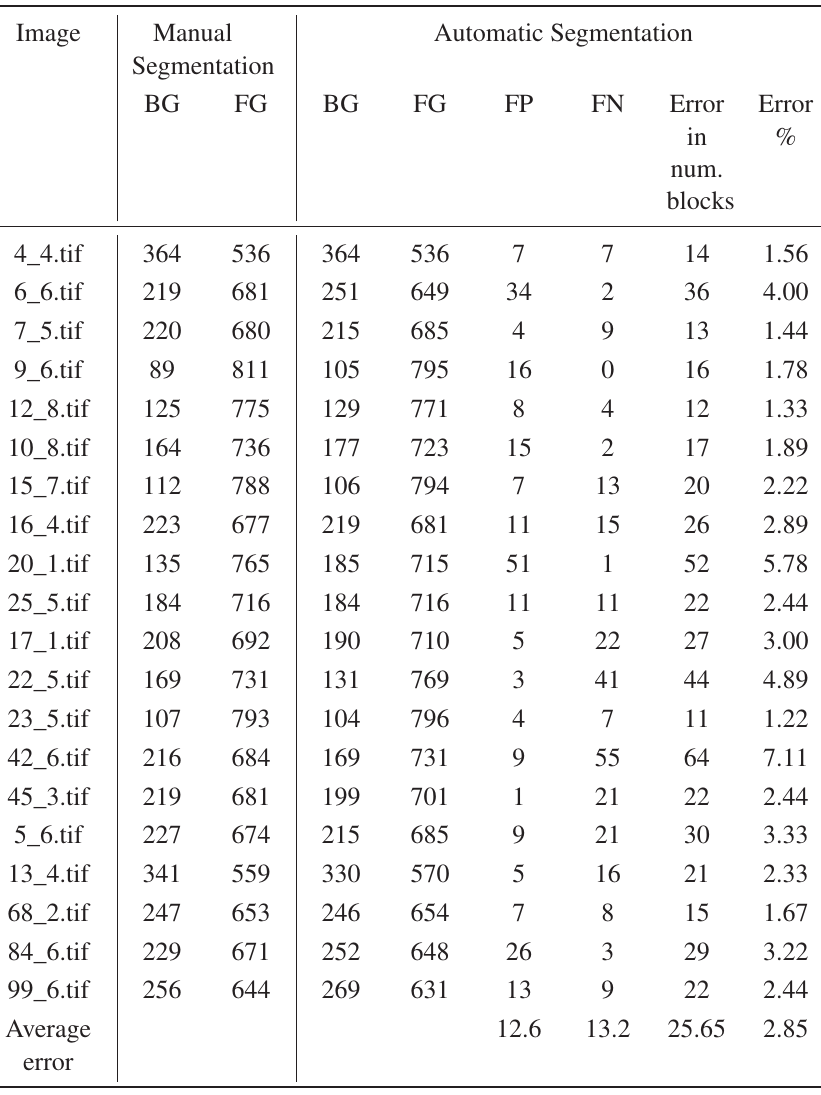
Table 3. Error analysis of images under